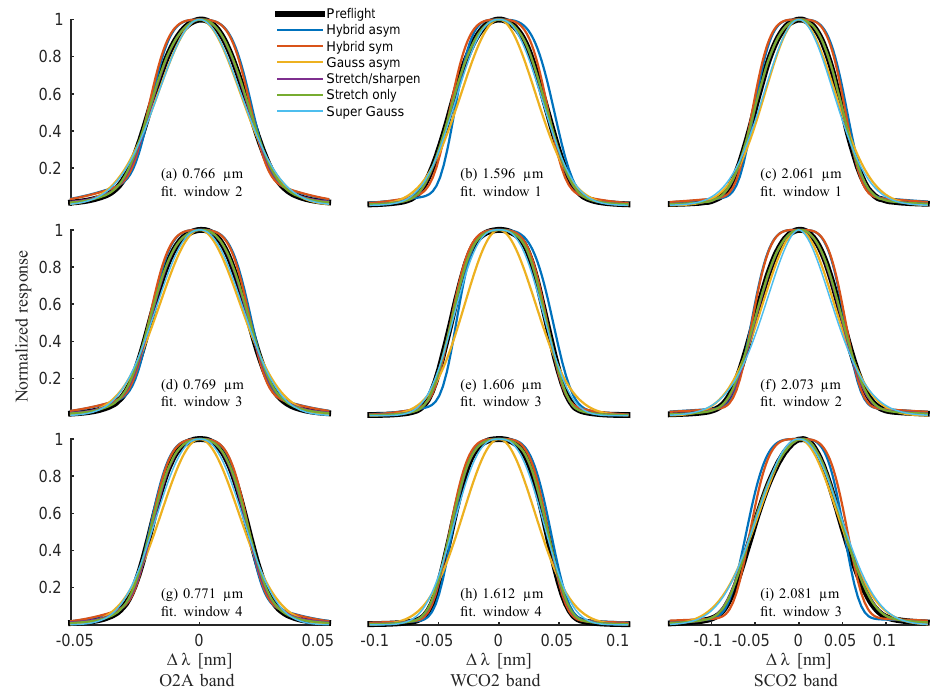
Figure 6. Comparison of the derived ILS functions using different function forms with the preflight ILS at three fitting windows for each band. The window numbers are consistent with Fig. 2. The same data from Fig. 5 are shown (footprint 6 on 29 March 2015).